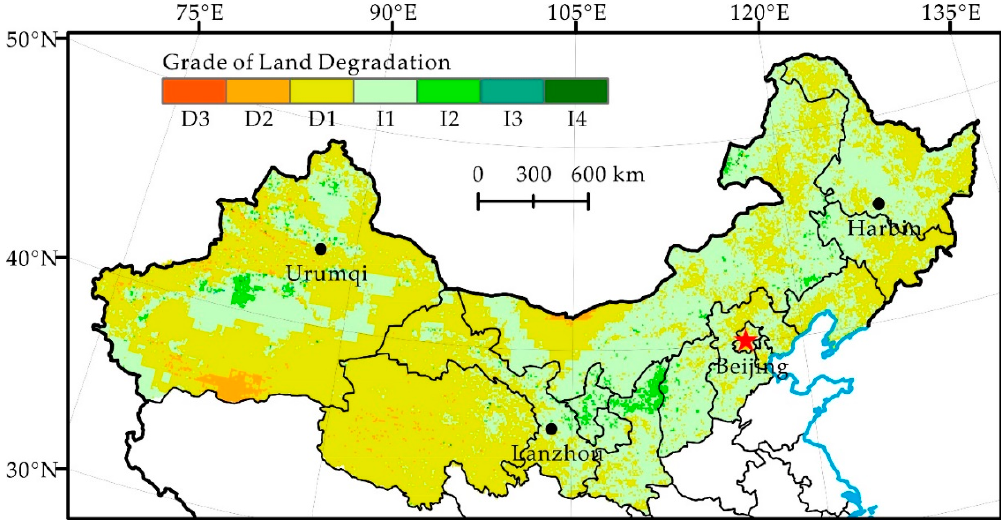
Figure 6. Distribution of Grade of Land Degradation during 1982–2012 in Northern China.